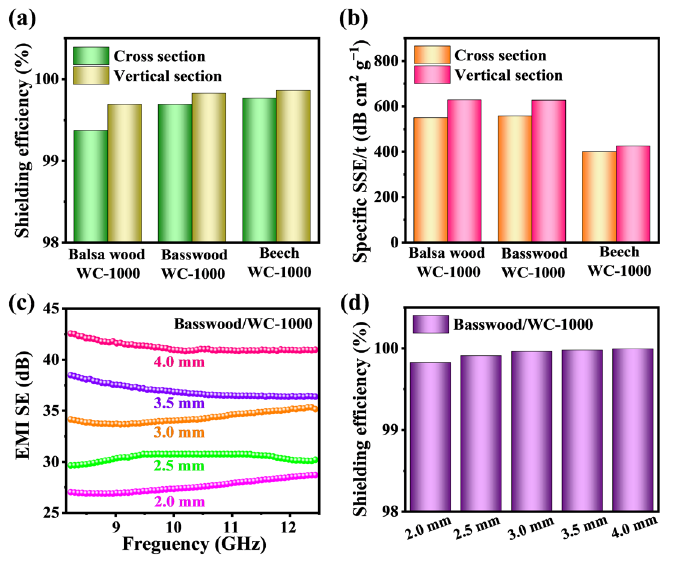
Figure 6. ( a ) EMI shielding efficiencies and ( b ) SSE/t values of WC-1000 (balsa wood, basswood and beech) under different sections. ( c ) EMI SE T and ( d ) EMI shielding efficiencies of WC-1000 of basswood at different thicknesses.